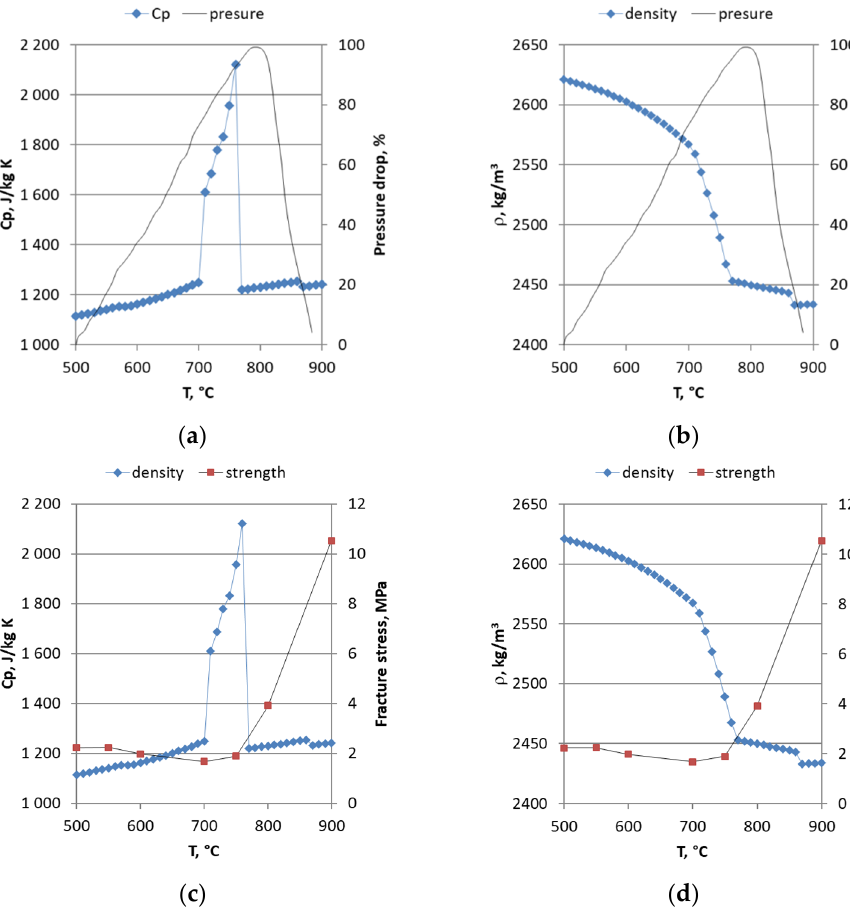
Figure 9. Wheat straw: ( a ) Specific heat (c p ) and pressure drop as a function of temperature; ( b ) density ( ρ ) and pressure drop as a function of temperature; ( c ) specific heat and fracture stress as a function of temperature; ( d ) density and fracture stress as a function of temperature.